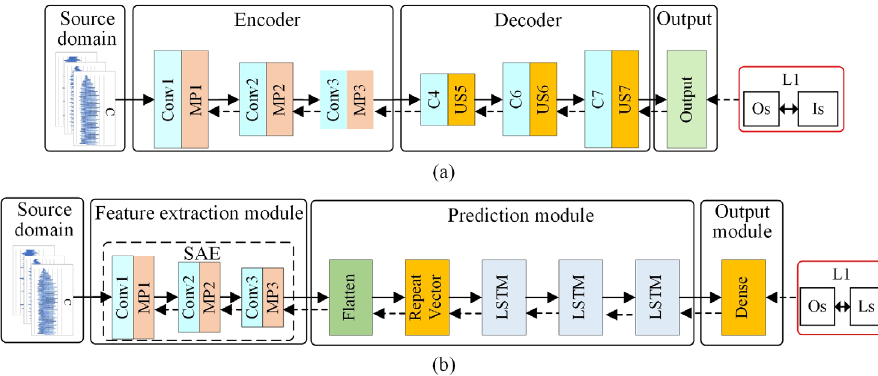
Figure 5. Schematic of pre-training: ( a ) SAE pre-training; ( b ) SAE–LSTM pre-training.